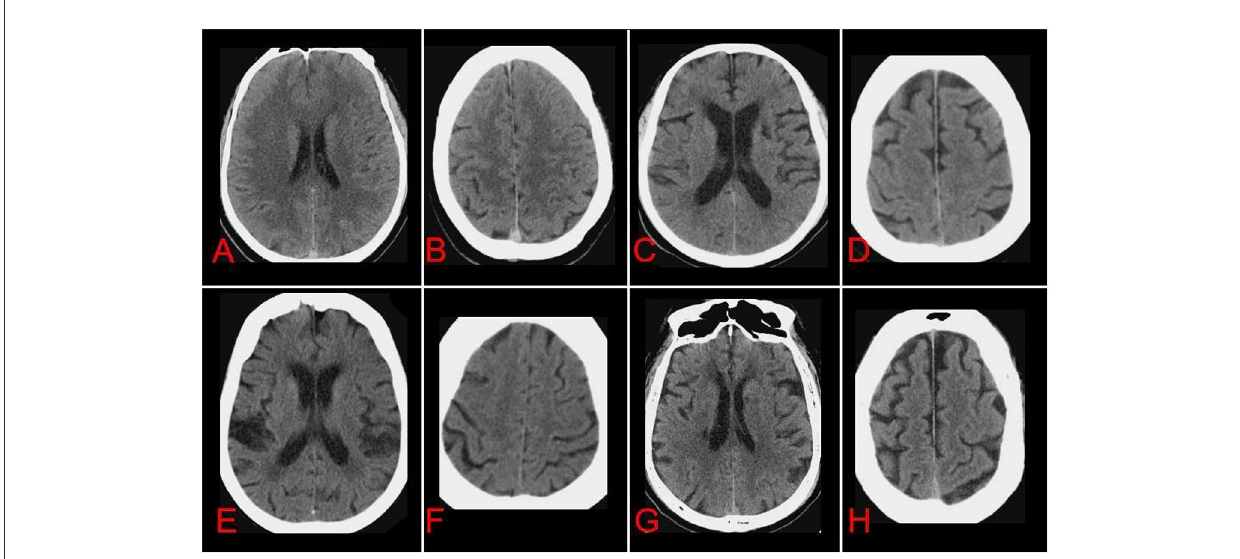
FIGURE1 Axial non-contrast-enhanced CT images of brains from patients after acute ischemic stroke at the level of choroid plexus (A, C, E, G) or semioval center (B, D, F, H) of the lateral ventricle. Cerebral small-vessel disease (CSVD) markers were individually assessed and graded according to the appropriate scales, and total CSVD burden was calculated. Images in (A, B) are representative of patients with total CSVD burden of 0: anterior leukoaraiosis = 0, posterior leukoaraiosis = 0, no lacune, central atrophy = 0, cortical atrophy = 0. Images in (C, D) are representative of patients with total CSVD burden of 1: anterior leukoaraiosis = 1, posterior leukoaraiosis = 1, no lacune, central atrophy = 2, cortical atrophy = 1. Images in (E, F) are representative of patients with total CSVD burden of 2: anterior leukoaraiosis = 2, posterior leukoaraiosis = 2, no lacune, central atrophy = 2, cortical atrophy = 1. Images in (G, H) are representative of patients with total CSVD burden of 3: anterior leukoaraiosis = 2, posterior leukoaraiosis = 1, lacune in left and right basal ganglia = 2, central atrophy = 2, cortical atrophy = 2.